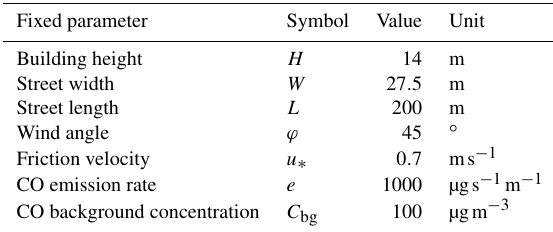
Table D1. List of parameters fixed in MUNICH simulation. Fixed